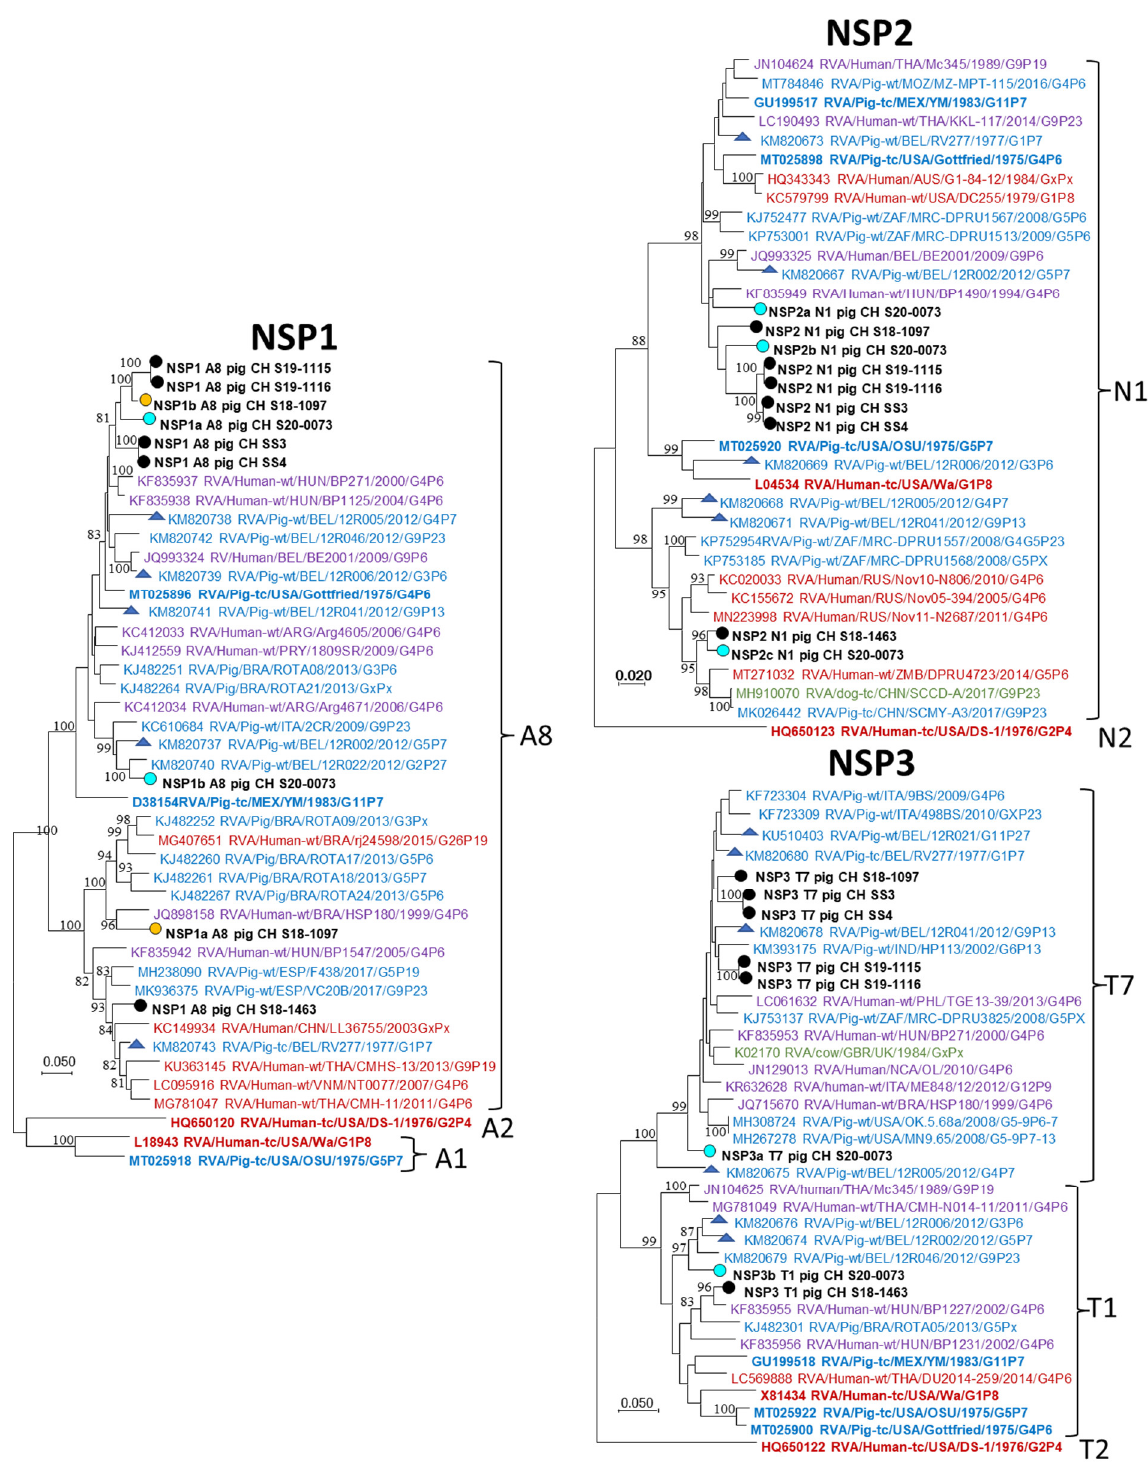
Figure 7. Maximum likelihood phylogenetic trees of the CDS of NSP1, NSP2 and, NSP3 sequences. RVA strains from this study are highlighted with circles, and names are written in bold black letters. Circle fill-colors blue and yellow indicate the common origin of co-infecting sequences. Letters after the protein ID of the Swiss strains (e.g., NSP1a and NSP1b) indicate multiple sequences for the CDS of this segment. The reference strains included in Table 1 are highlighted in bold and Belgian references with triangles. A legend of the color codes of the strain names is provided in Figure 5.